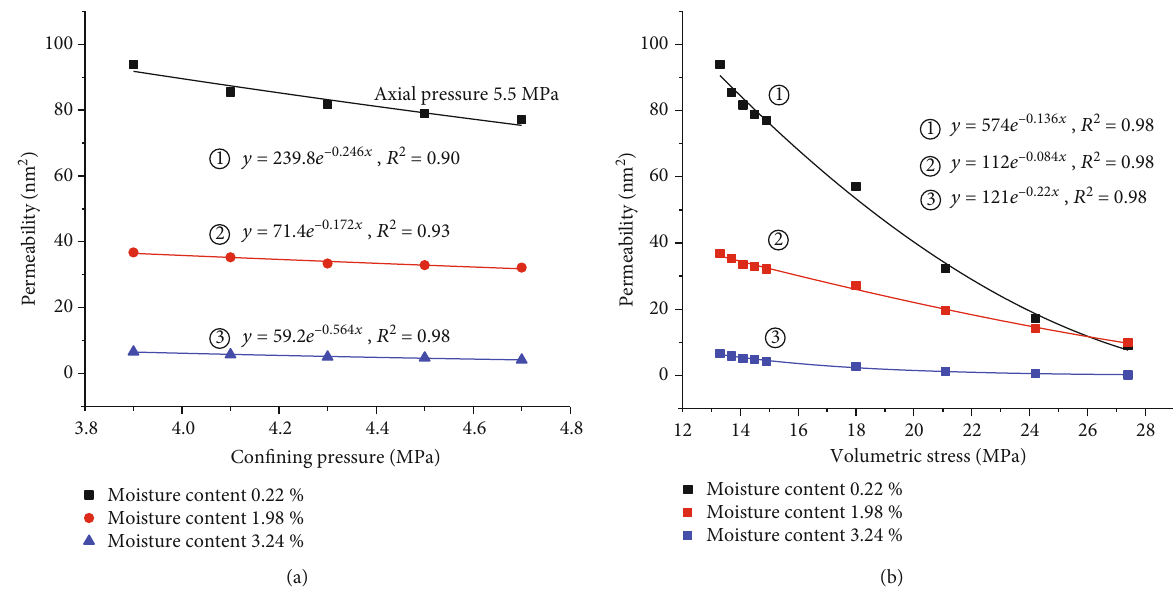
Figure 9: E ff ect of in-situ stress on permeability: (a) con fi ning pressure; (b) volumetric stress.